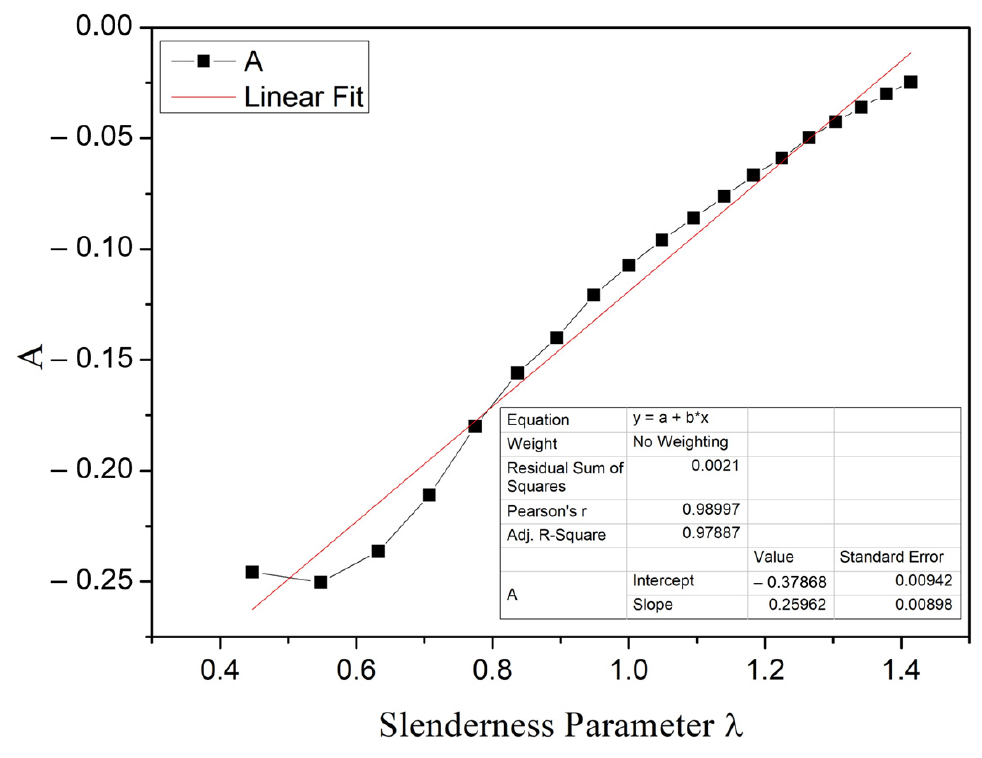
Figure 9. Regression Analysis for Coefficient A.